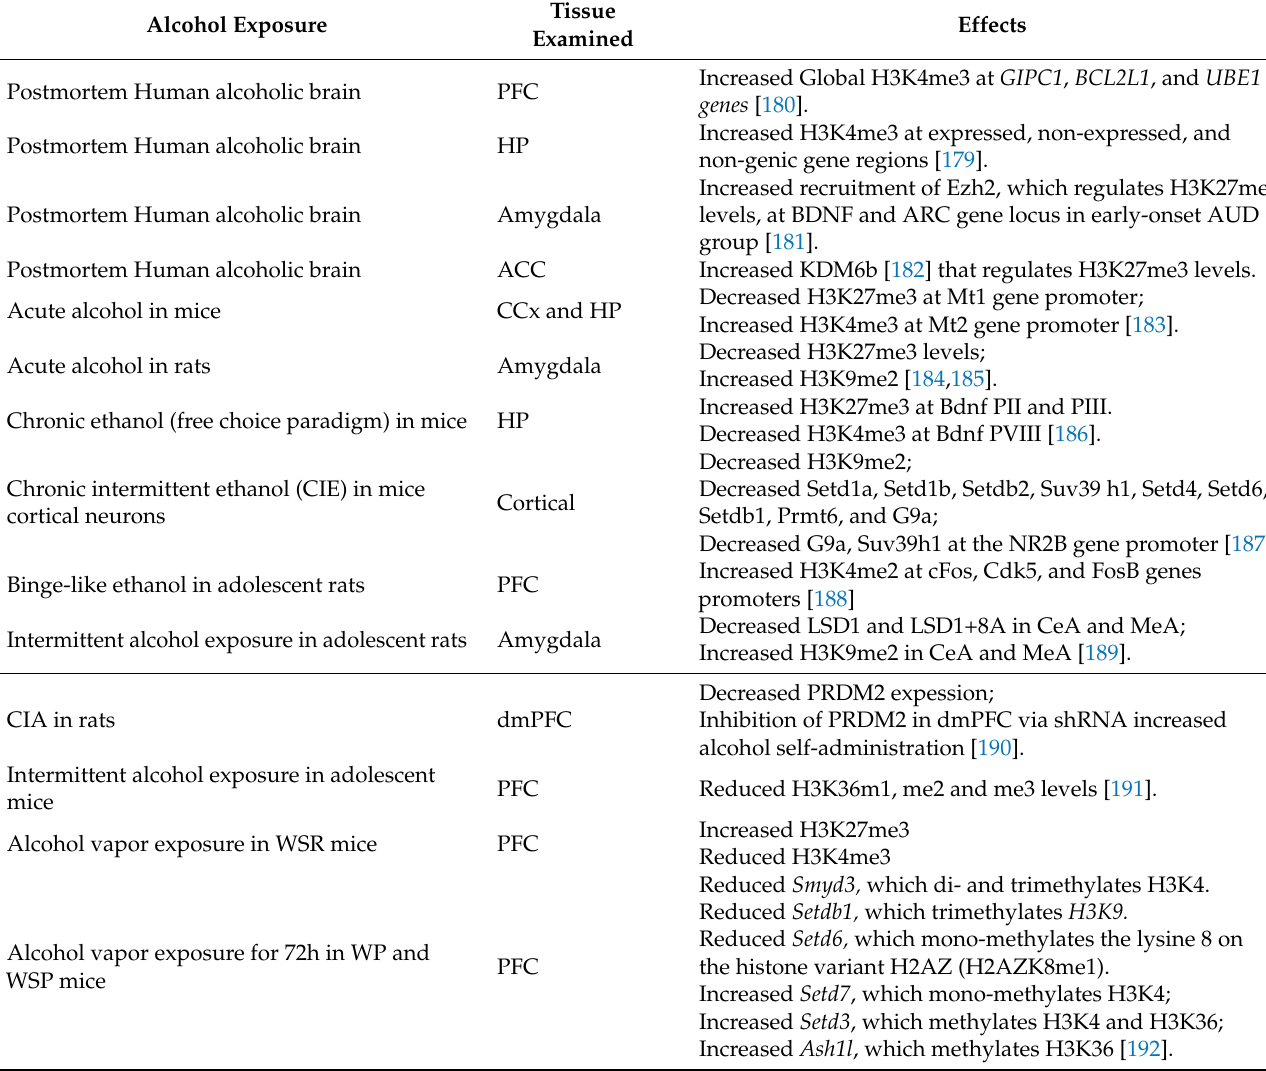
Table 2. Influence of alcohol exposure on brain histone methylation